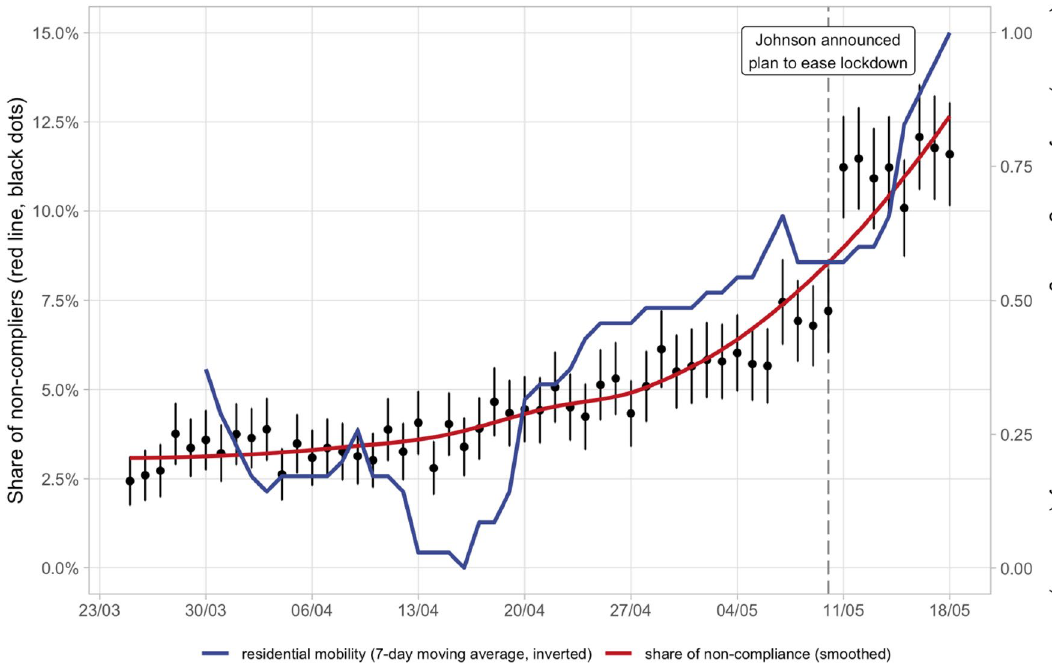
Figure 1. The share of non-compliers steadily increasing from end of March until mid of May. On the 10th of May 2020, Prime Minister Johnson announced the government’s plan of exiting lockdown, which led to a significant jump of the share of non-compliers. The plot shows the average non-compliance shares for each day (black dots) with the corresponding 95% confidence intervals represented by the vertical lines (sample weights are applied). The red line is a smoothing function based on non-compliance averages from previous days. The blue line represents the (inverted and rescaled to a 0–1 range) 7-day-moving-average of the residential